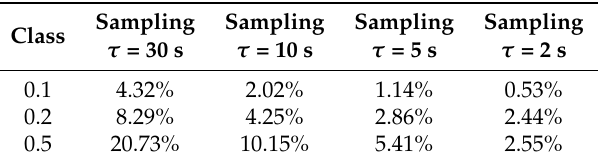
Table 4. Mean relative error of the line temperature estimation method for a complete set of noise-containing data.